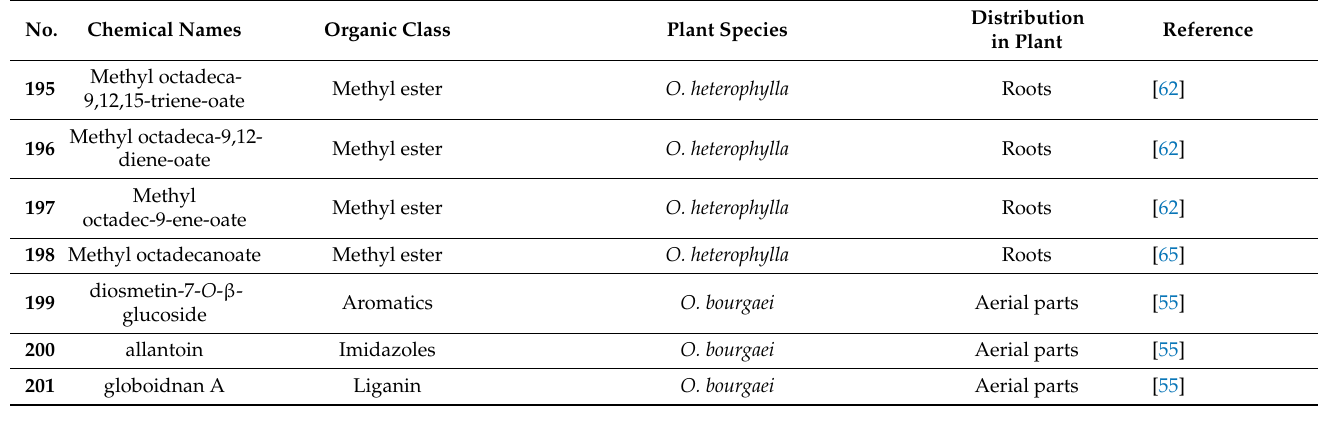
Figure 4. Organic class contents of Onosma species based on reported compounds.